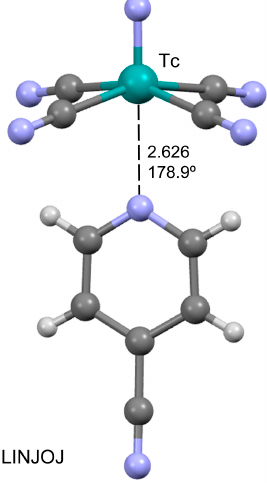
Figure 7. Ball and stick representation of the X-ray structure LINJOJ. Counter-cations omitted. Distance in Å. Color code: Carbon grey, Nitrogen blue, Technetium teal, Hydrogen light grey.